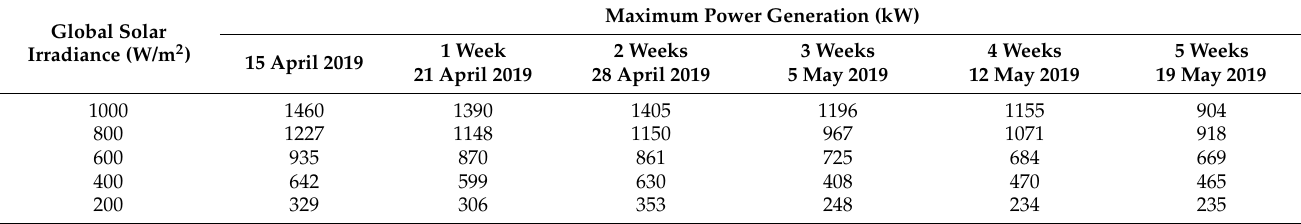
Table 5. Power generation under different solar irradiance with weekly intervals.